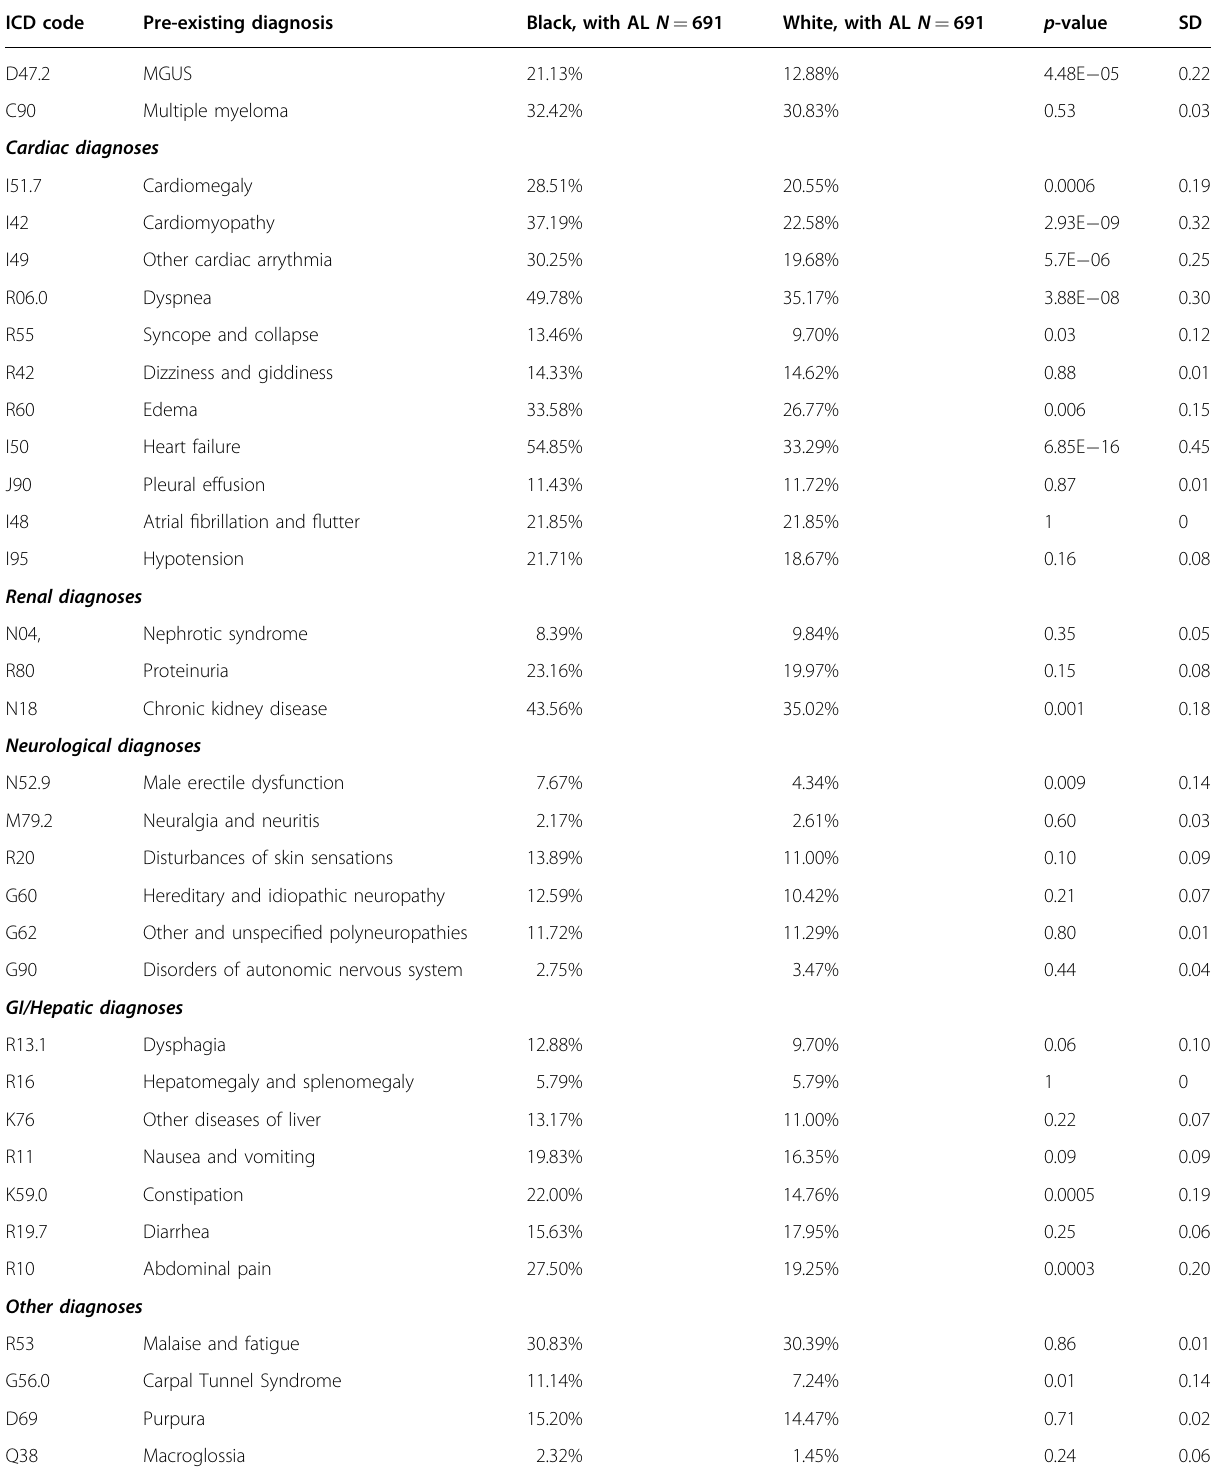
Table 1 Comparison of pre-existing diagnoses in AL amyloidosis by race.